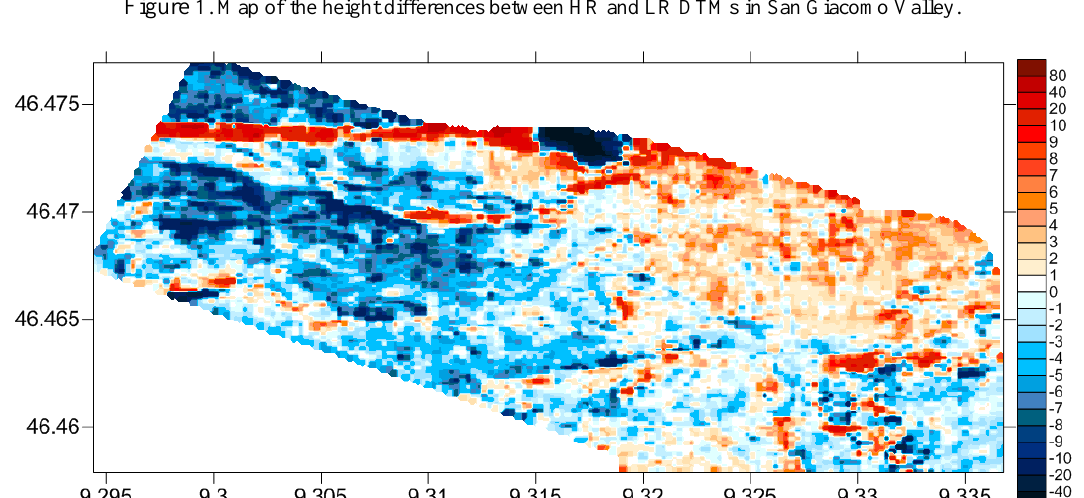
Figure 2. HR-LR differences in the valley of S.Giacomo. The presence of systematic patterns is clear (biases with opposite signs on the valley left and right slopes are hardly